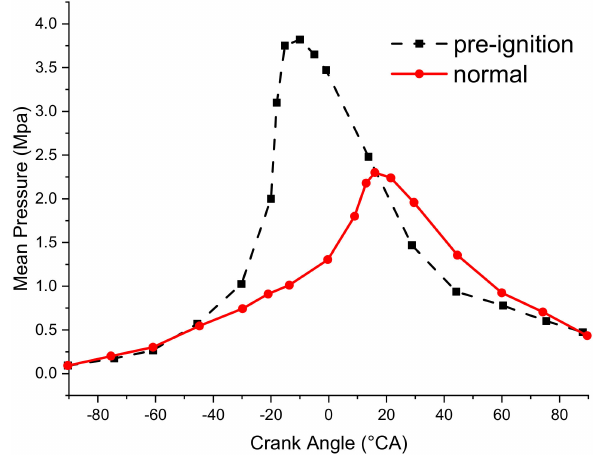
Figure 12. The pressure comparison for the normal combustion and the